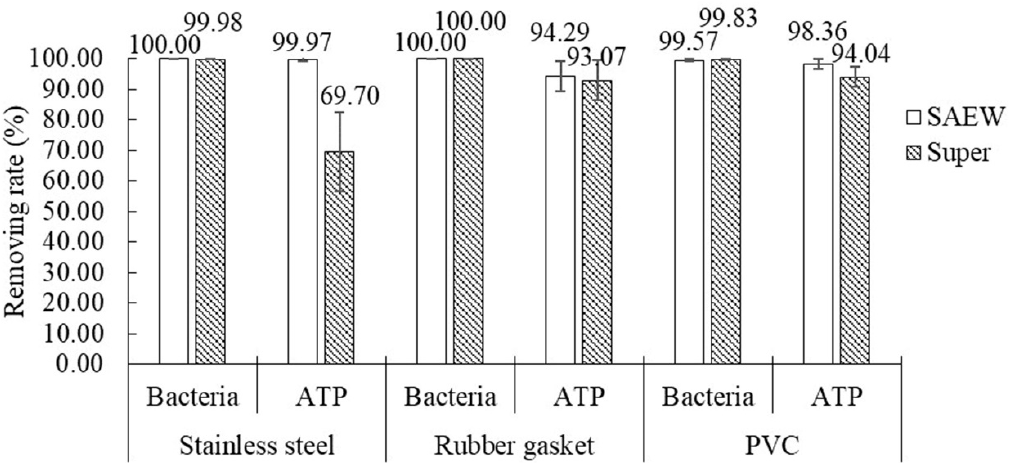
Figure 3. Comparison of bacteria and ATP removal rates for three materials after treatment with SAEW using the optimized parameters and commercial detergent (“super”). The required SAEW treatment time, cleaning temperature, and ACC were 9.9 min, 37.8 ◦ C, and 60 mg / L to clean stainless steel; and were 14.4 min, 29.6 ◦ C, and 60 mg / L to clean rubber gasket and PVC samples, respectively.